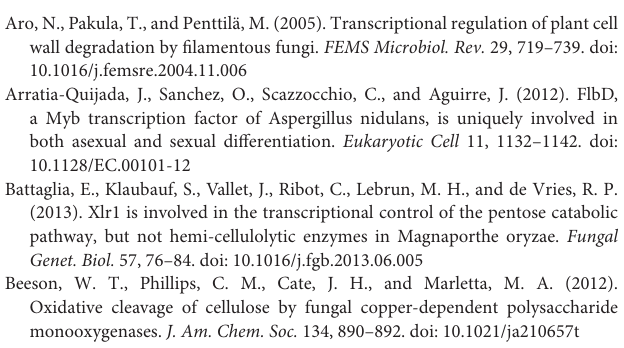
Figure S3 | Biological replicates used for the RNA-seq analysis ( ∆ xyr1 ). (A–I) Graphs representing the Pearson correlation between biological replicates of each sample demonstrating the reliability of RNA-seq ( R ≥ 0 .67).